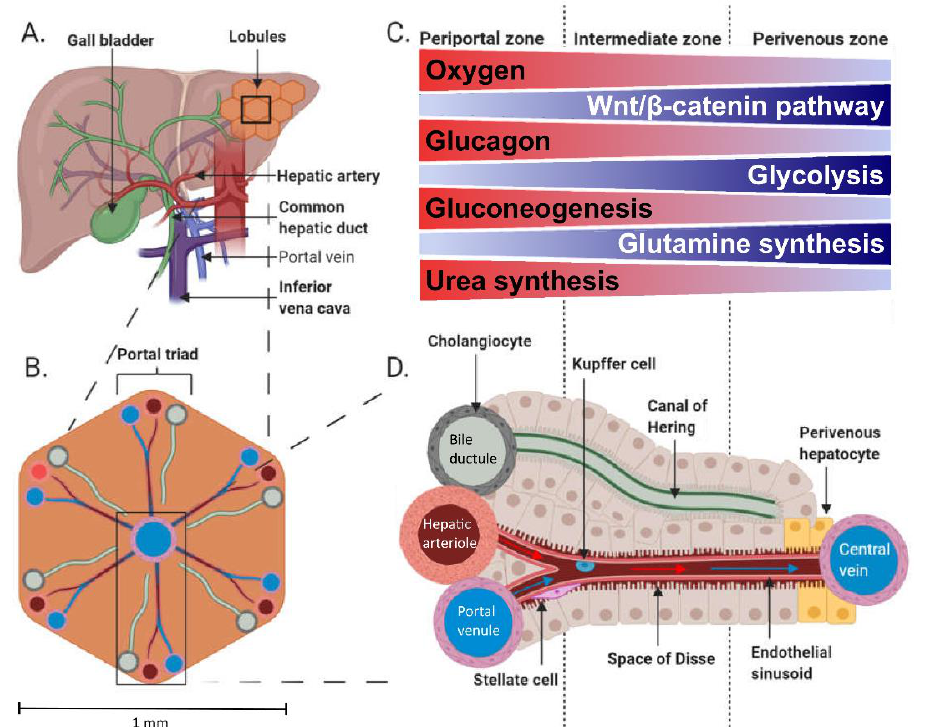
Figure 1. Anatomy ( A ) and physiology of the human liver. The microstructure of the liver consists of small, generally hexagonal lobules ( B ). The portal triads comprising a portal venule, hepatic arteriole and bile ductule are located at the corners of the lobules. The acinus is divided into three zones ( C ), periportal, intermediate and perivenous, with varying environment and metabolic activities according to the location between the portal triad and central vein ( D ). The acinus comprises a sinusoid connecting hepatic arteriole and portal venule with the central vein where proteins and metabolites are exchanged in the plasma-containing space of Dissé. Bile secreted from the hepatocytes drains into a canal of Hering, which empties into a bile ductule. ( A , B ) and ( D ) are adapted from [4] and C from [5] under Creative Commons Attribution 4.0 International License (http://creativecommons.org/licenses/by/4.0/, accessed on 17 January 2022).